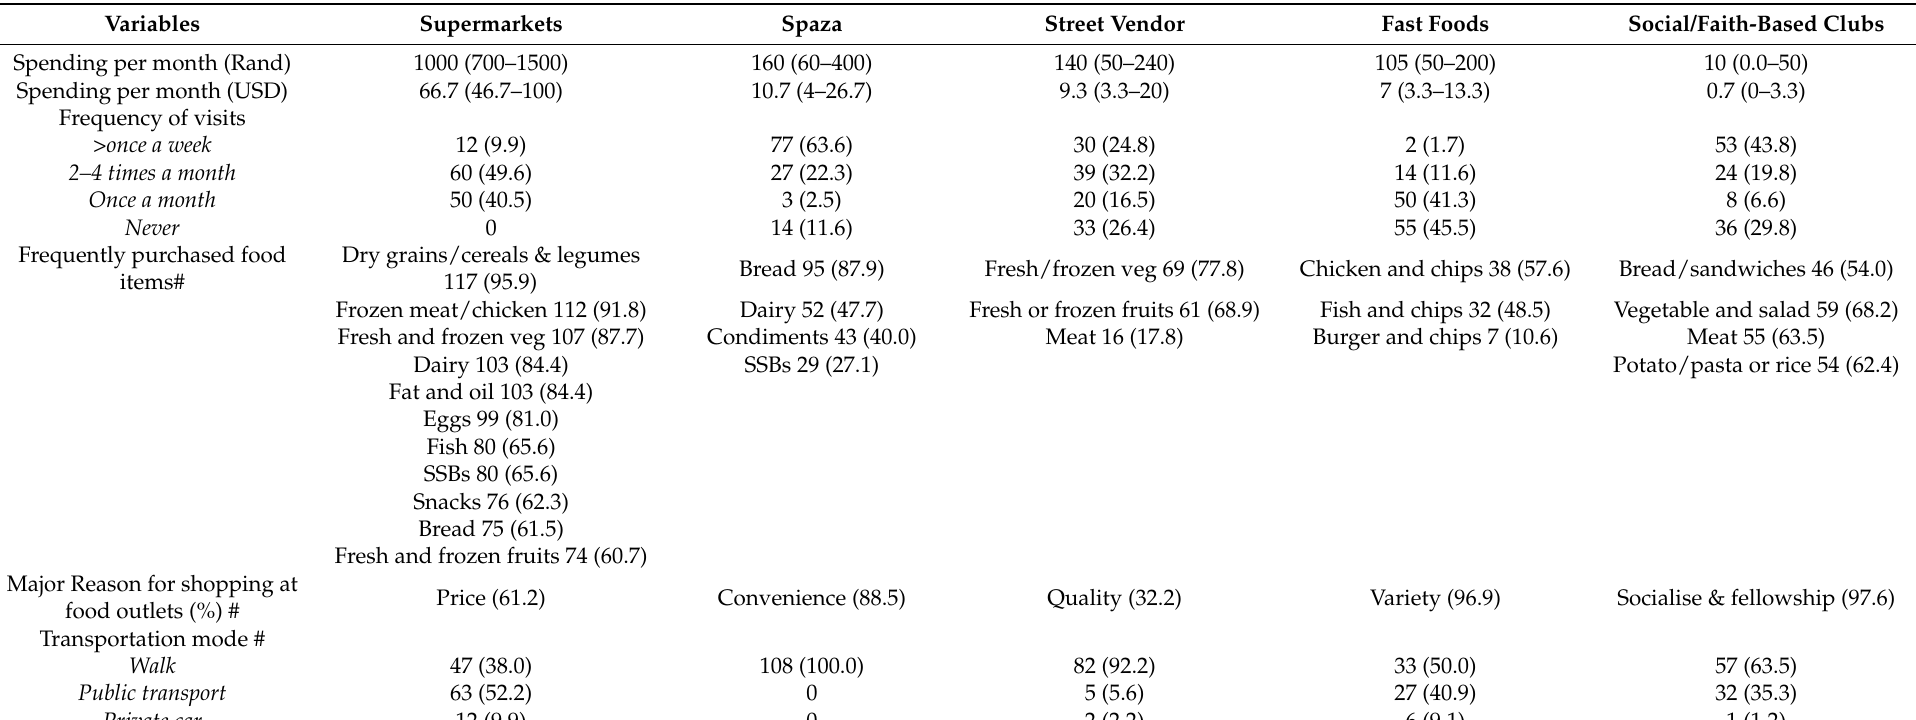
Table 3. Neighbourhood food environment and food acquisition characteristics of low-income older South African